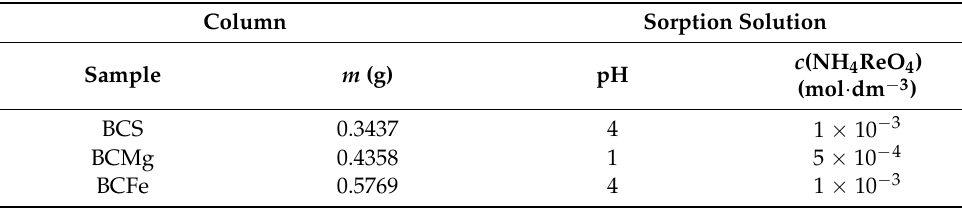
Table 1. Composition of sorption solutions and column bed